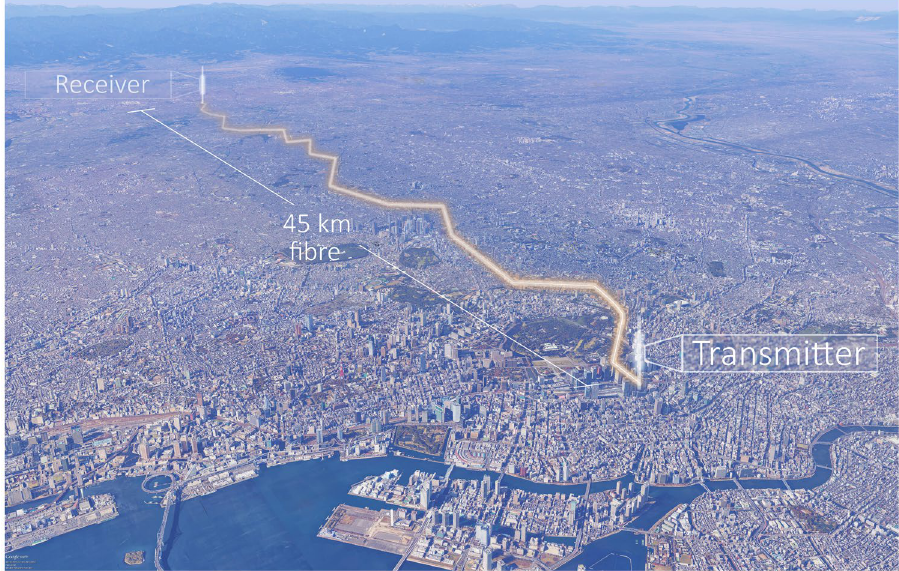
Figure 4. Location of the field trial of the QKD system, with the transmitter sited in central Tokyo and the receiver towards the western edge of the city. The two locations are connected by an installed telecom fibre pair with a length of 45 km and loss of 14.5 dB. Map data courtesy of: Google Earth, SIO, NOAA, U.S. Navy, NGA, GEBCO, Image Landsat and Japan Hydrographic Association.